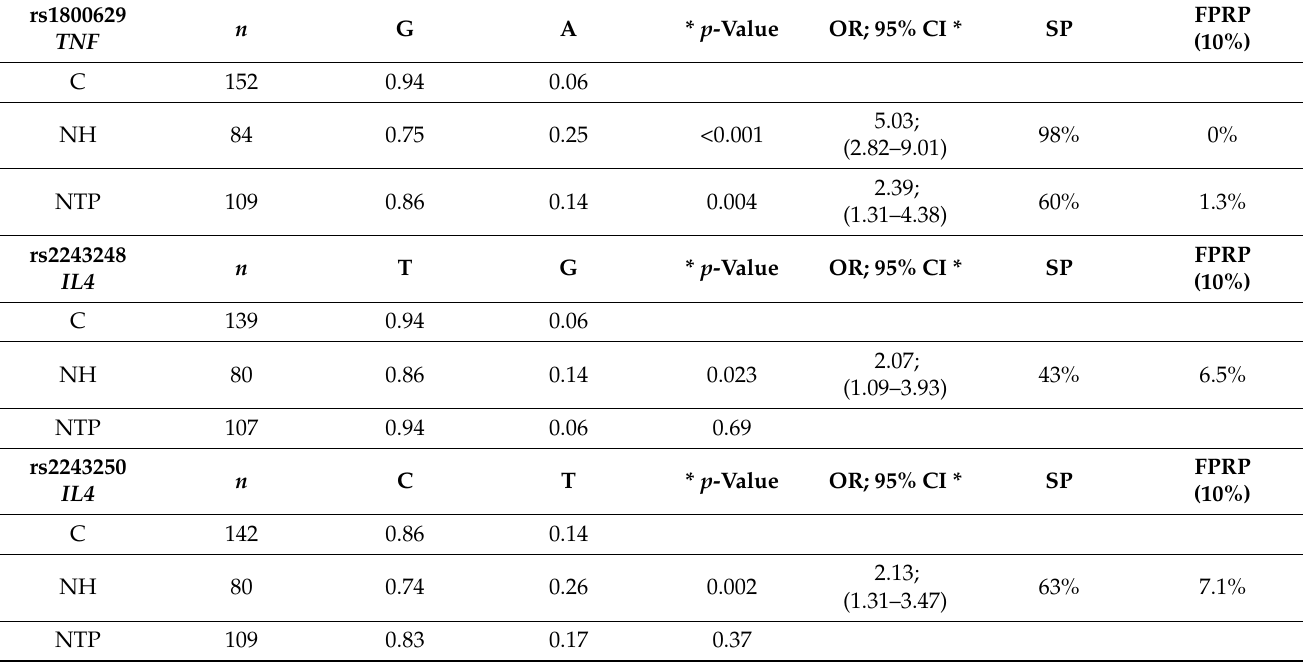
Table 3. Allelic frequency distributions of SNPs showed a significant association in NSAID hypersen- sitivity and NSAID-tolerant patients compared with